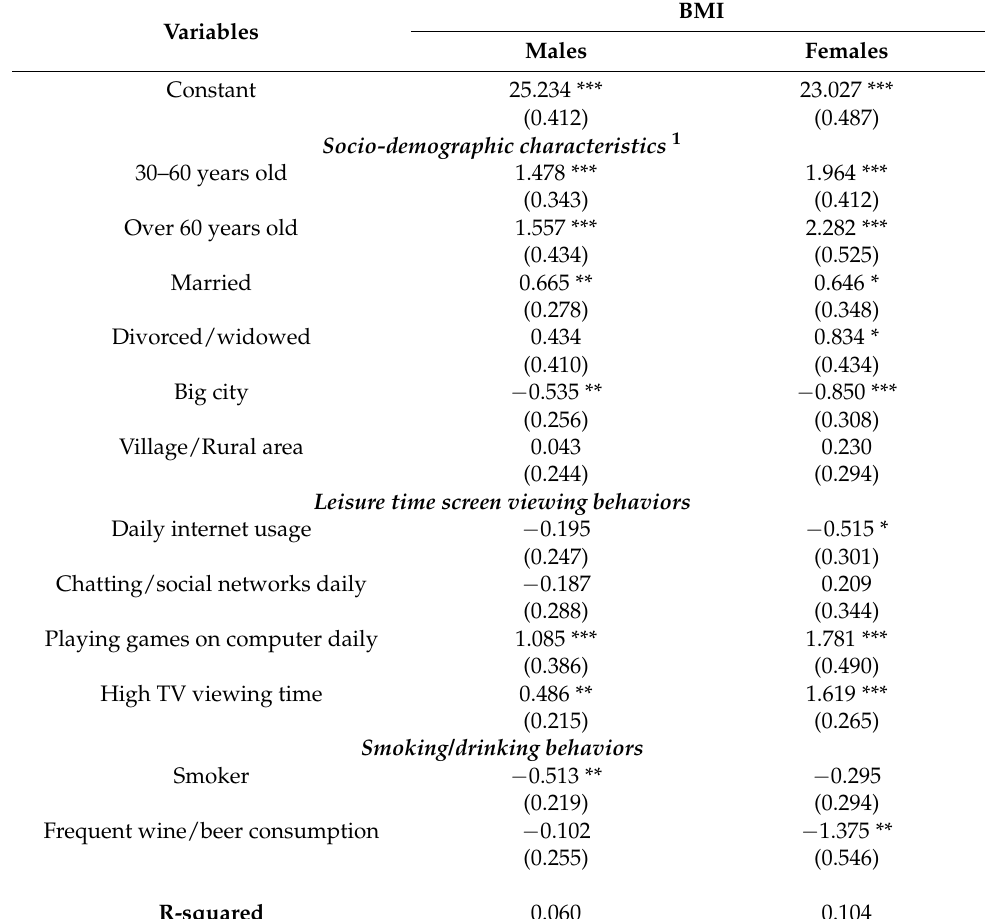
Table 4. OLS estimates for